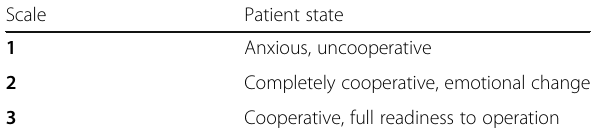
Table 2 Anxiety scale (Ramsay et al., 1974)